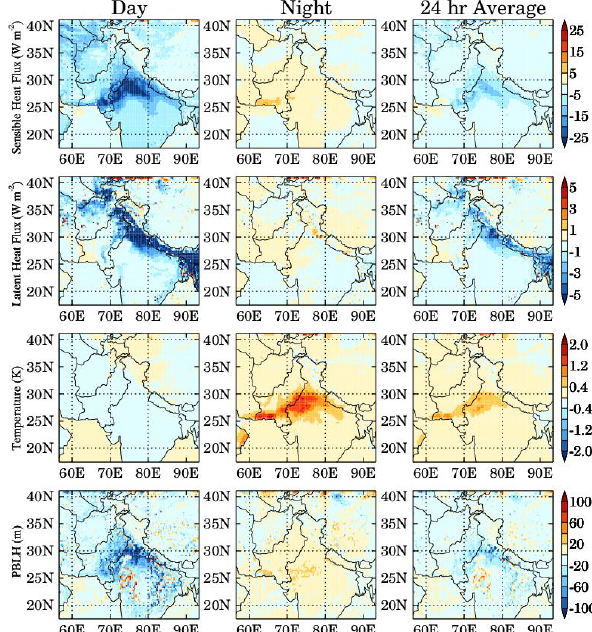
Fig. 12. Spatial distributions of changes in daytime (07:30– 18:30IST), nighttime (18:30–07:30IST) and 24h average sensible heat flux, latent heat flux, 2m temperature and planetary boundary layer height during 17–22 April 2010. The changes are calculated by comparing two parallel WRF-Chem simulations with and with- out